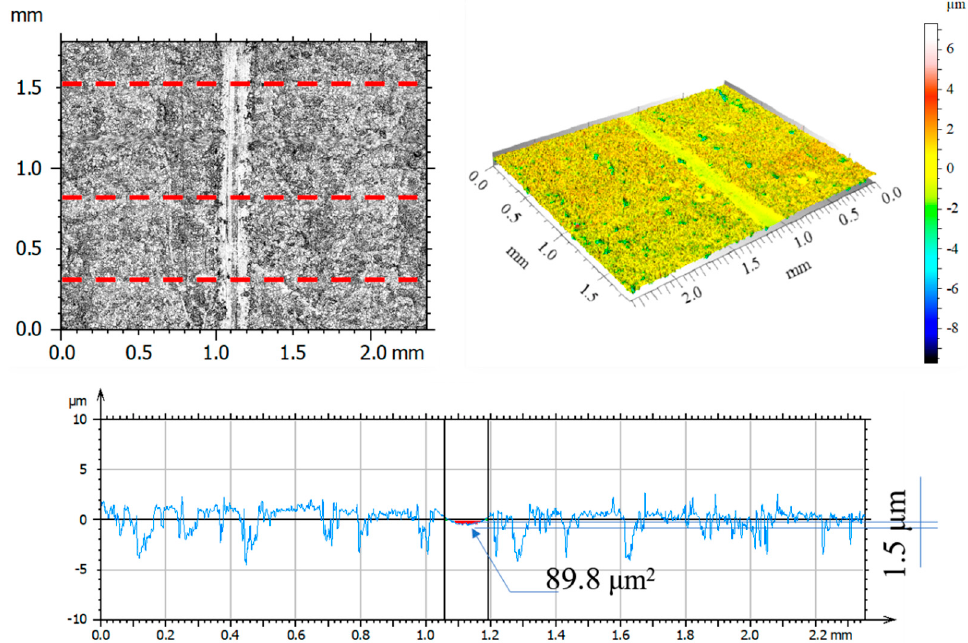
Figure 12. Optical and axonometric views of sample wear track and the wear profile on transverse cross-section after the dry sliding of the nitrogen ion-implanted steel 316L—Al 2 O 3 friction pair.